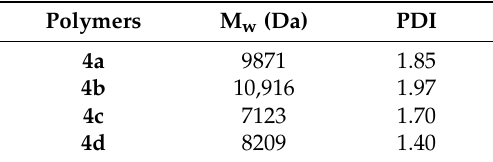
Table 1. Molecular weights and polydispersities of the target polymers.